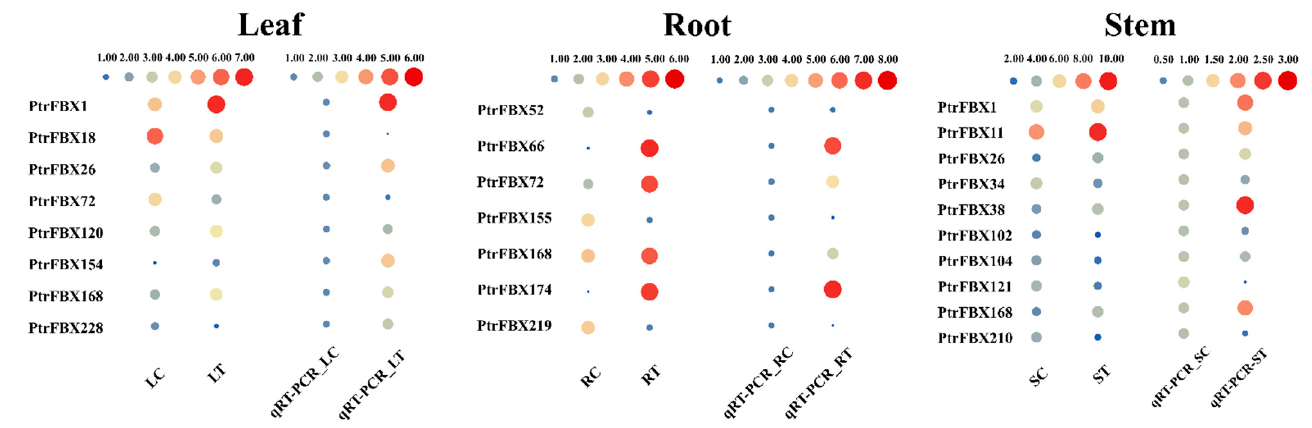
Figure 7. Relative expression level of DEGs under salt stress based on RNA-Seq and qRT-PCR across the three tissues of Populus simonii × Populus nigra . The gene relative expression was calculated, based on the expression level of each gene without salt treatment. Blue and red circles represent relatively high and low expression, respectively. The size of the circle represents the relative expression level. The larger the circle, the higher the relative expression level of the gene.